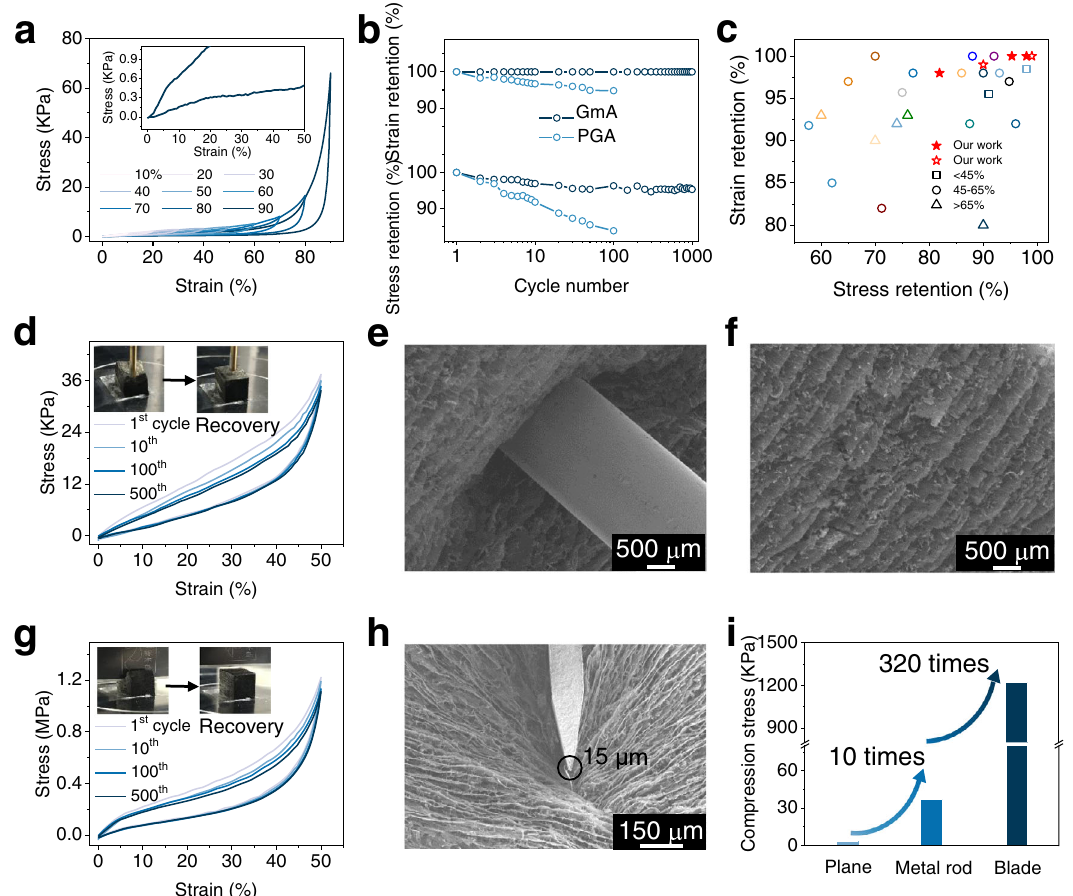
Fig.3|SuperiormechanicalperformancesofGmAs.a Compressivestress – strain curves of GmA at strain up to 90%, inset the zoom-up curve of 90% strain. b The strain and stress retention of GmA and pristine graphene aerogel (PGA) during 1000cyclesat50%strain. c Extensivecomparisonofthestrainretentionandstress retentionofGmAandreportedcarbonbasedaerogels 8,9,11,14,23 – 26,34 – 43 .Starsrepresent the results in this work, and the open stars represent the GmA after pre- compression. d Stress – strain curves of GmA at 50% strain for 500 cycles under metal rod compression with a compressive area of only3.1 mm 2 . The insets are the